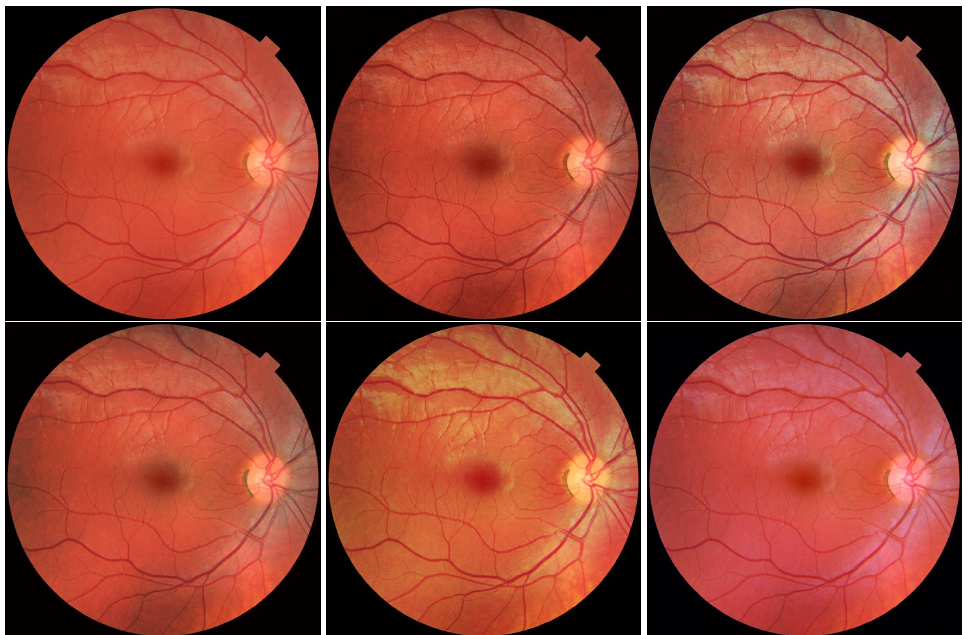
Figure 19. Results of the CLAHE algorithm for an exemplary colour image ( top left ). We use CLAHE on different image channels: V from HSV model ( top centre ), R, B and G from RGB model together ( top right ), and separately R ( bottom left ), G ( bottom centre ), B ( bottom right